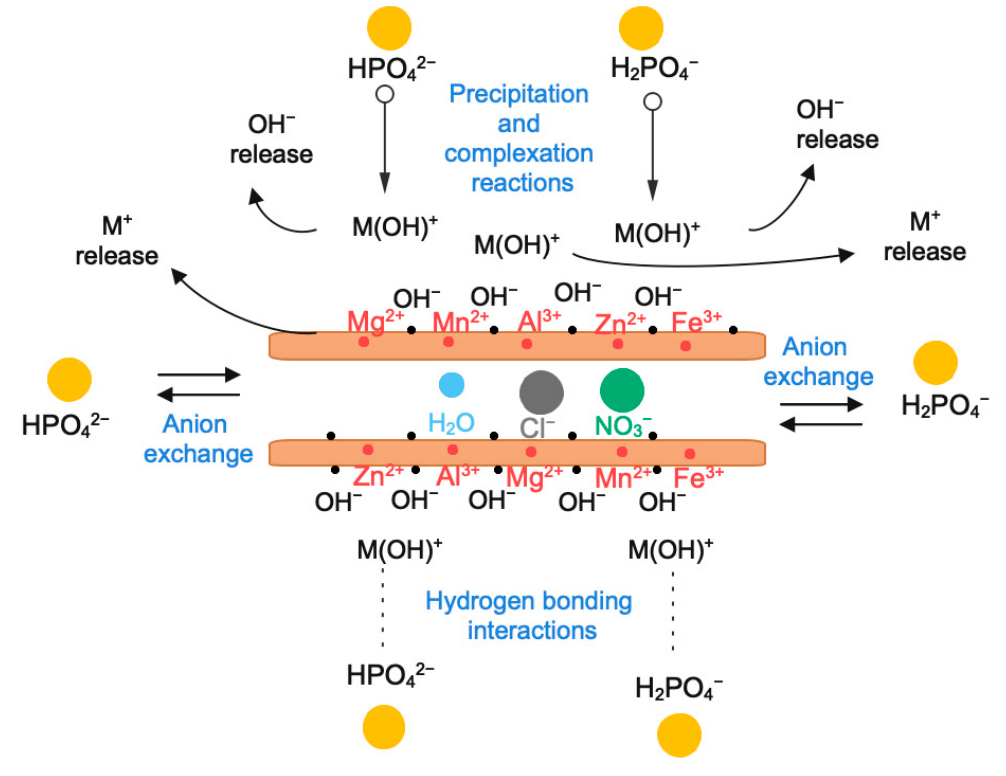
Figure 5. Phosphate adsorption mechanisms onto Mn 2+ /Zn 2+ /Fe 3+ /Mg-Al-LDH composite at pH 7.5.